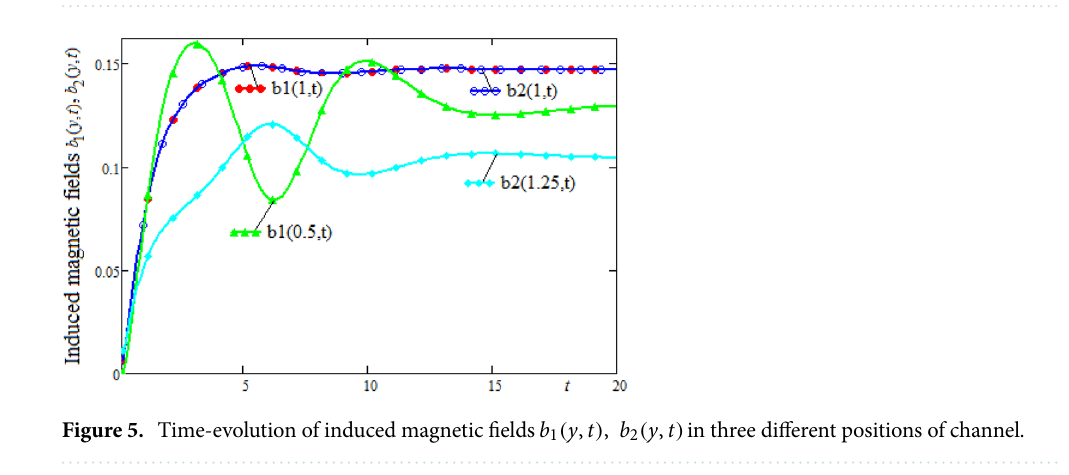
Figure 4. The profiles of induced magnetic fields b 1 ( y , t ) , b 2 ( y , t ) versus y for different values of the time t.